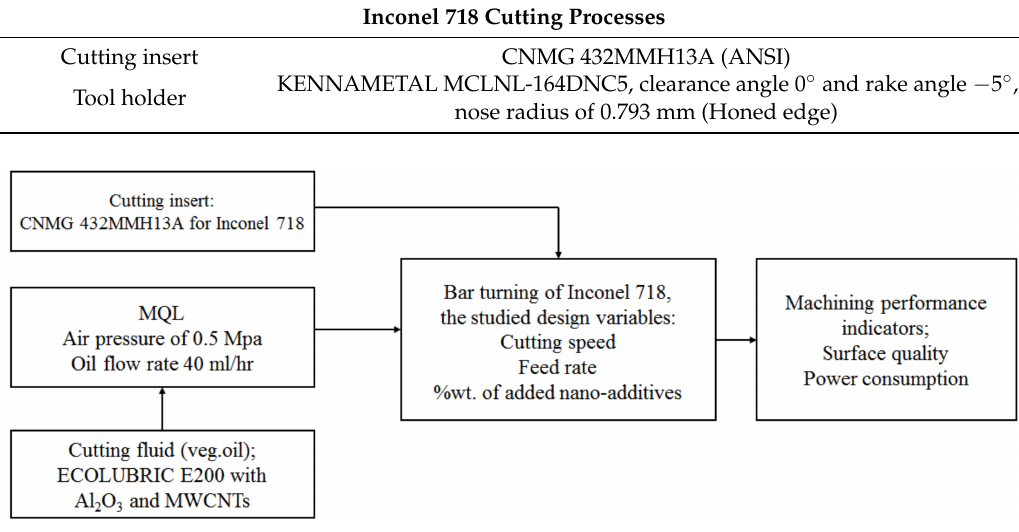
Figure 1. Schematic of the experimentation